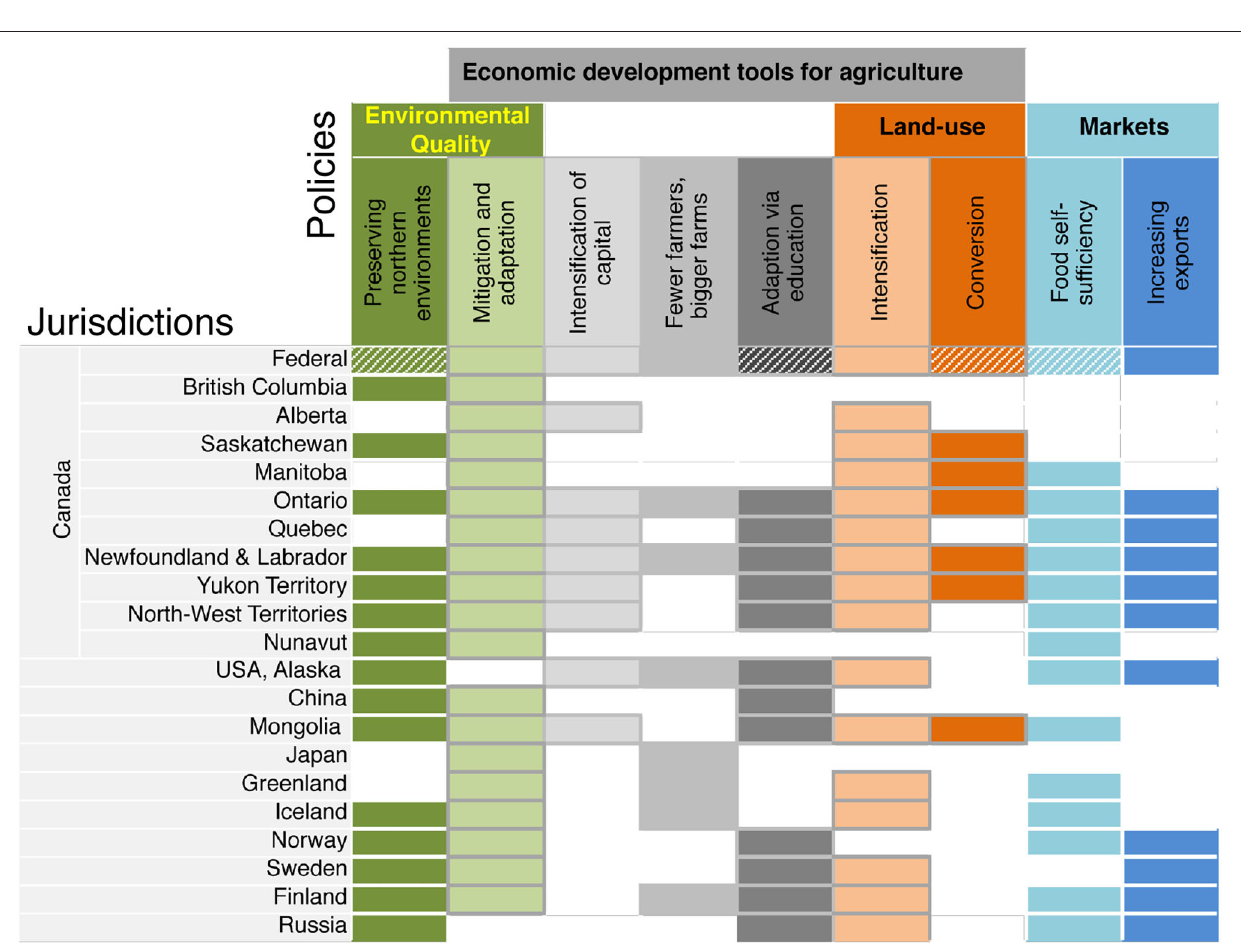
FIGURE 2 | Trends and agricultural policy preparedness for northern climatic shifts (Government of Sweden, 1993; Government of Saskatchewan, 1999, 2018, 2019; Tsogtbaatar, 2002; Ott, 2005; Yang et al., 2007; Government of the Russian Federation, 2009, 2018a,b, 2019; Deng et al., 2010; Gouvernement Du Québec, 2010, 2018, 2019; Government of Norway, 2010, 2017; Manitoba Agricultural Services Corporation, 2010, 2019; Ahern et al., 2011; Government Offices of Sweden, 2011, 2015; Government of Nunavut, 2011; Government of Ontario, 2011, 2016, 2018a,b; Government of Yukon, 2012, 2016, 2018a,b; Hammond et al., 2013; The Conservation of Arctic Flora and Fauna, 2013; Alaska Farm Bureau, 2014; ESTR Secretariat, 2014; Forbord et al., 2014; Government of Finland, 2014a,b, 2015, 2019; Nunavut Food Security Coalition, 2014; Stevenson et al., 2014c; United States Department of Agriculture, 2014, 2019; Government of Japan, 2015, 2018; Government of British Columbia, 2016, 2019; Government of Iceland, 2016, 2018; Government of Northwest Territories, 2016, 2018, 2019; Hohle et al., 2016; Naalakkersuisut (Government of Greenland), 2016, 2018; Parliament of Mongolia, 2016; Research Department of Arion Bank, 2016; State Council of the People’s Republic of China, 2016; State Great Khural of Mongolia, 2016; Statistics Canada, 2016, 2017; Agriculture and Agri-Food Canada, 2017, 2019; Chuluunbaatar et al., 2017; Government of Alberta, 2017, 2018; Government of Manitoba, 2017a,b,c,d; Government of Newfoundland and Labrador, 2017a,b,c,d,e, 2018a,b; Lehmann et al., 2017; Luke Finland, 2017; Research Northwest and Hershfield, 2017; Schou et al., 2017; Government of Canada, 2018; National Research Council of Canada, 2018; Niemi and Väre, 2018, 2019; Government of Alaska, 2019; Hokkaido Agricultural Administration Department, 2019; Manitoba Agriculture and Resource Development, 2019; National Statistics Office of Mongolia,